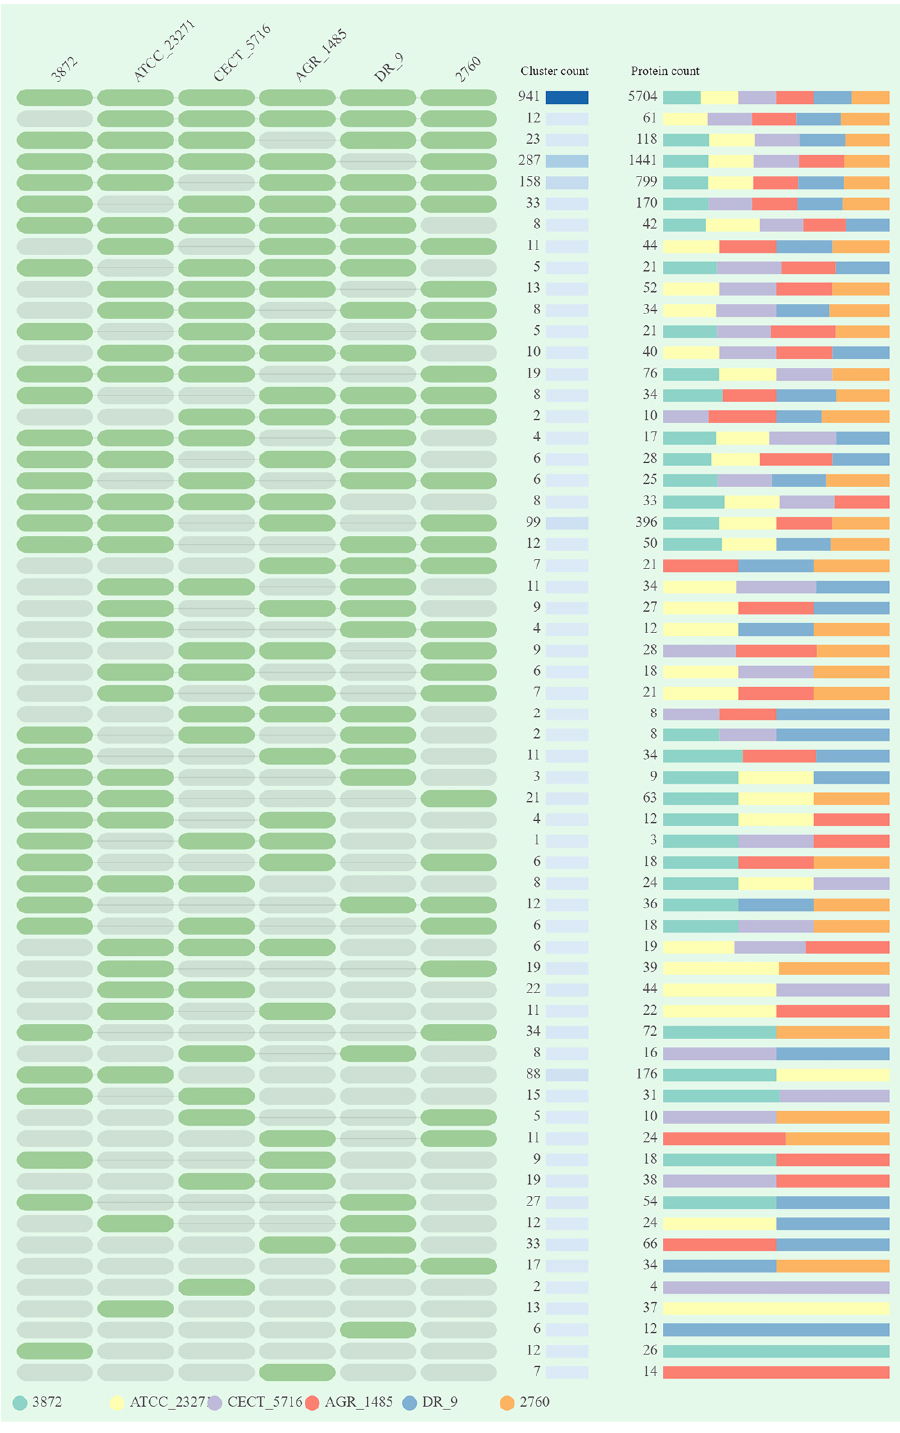
Figure 3. Overlays identified by the OrthoVenn 2 analysis of L. fermentum strains ATCC 23271, 2760, 3872, CECT 5716, AGR 1485 and DR 9.